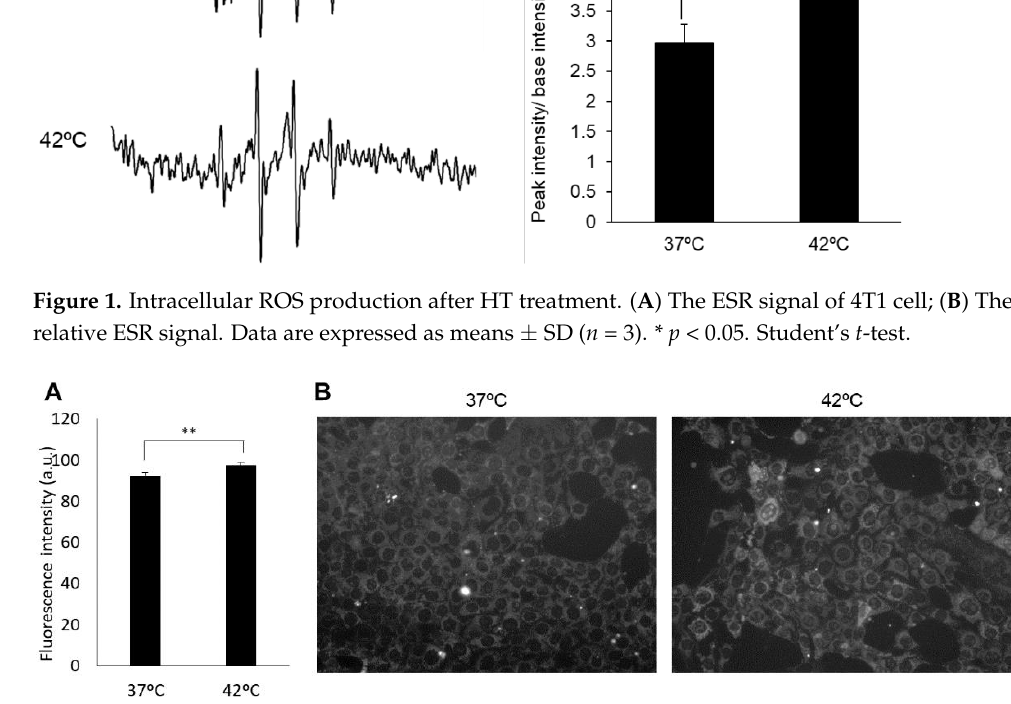
Figure 1. Intracellular ROS production after HT treatment. ( A ) The ESR signal of 4T1 cell; ( B ) The relative ESR signal. Data are expressed as means ± SD ( n = 3). * p < 0.05. Student’s t -test.